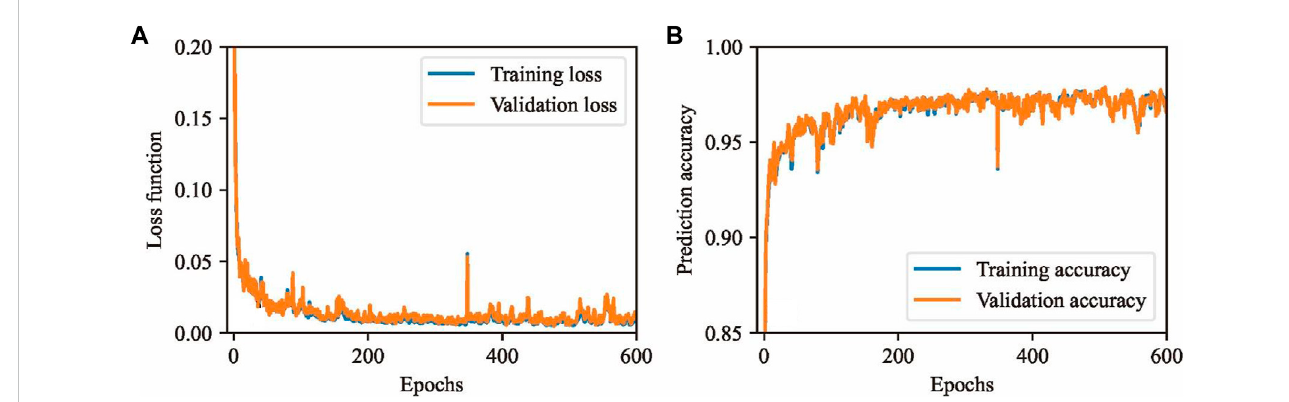
FIGURE 3 (A) Loss curve and (B) accuracy metric